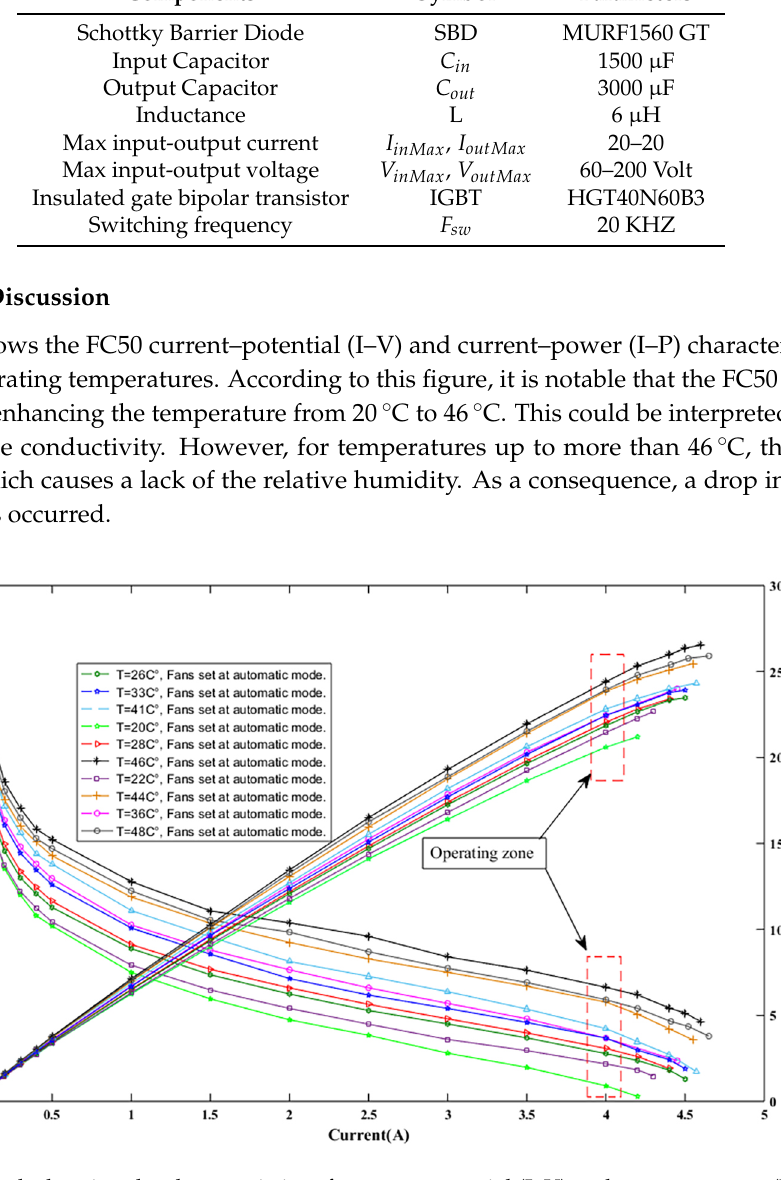
Figure 7. Graph showing the characteristics of current–potential (I–V) and current–power (I–P) for a different